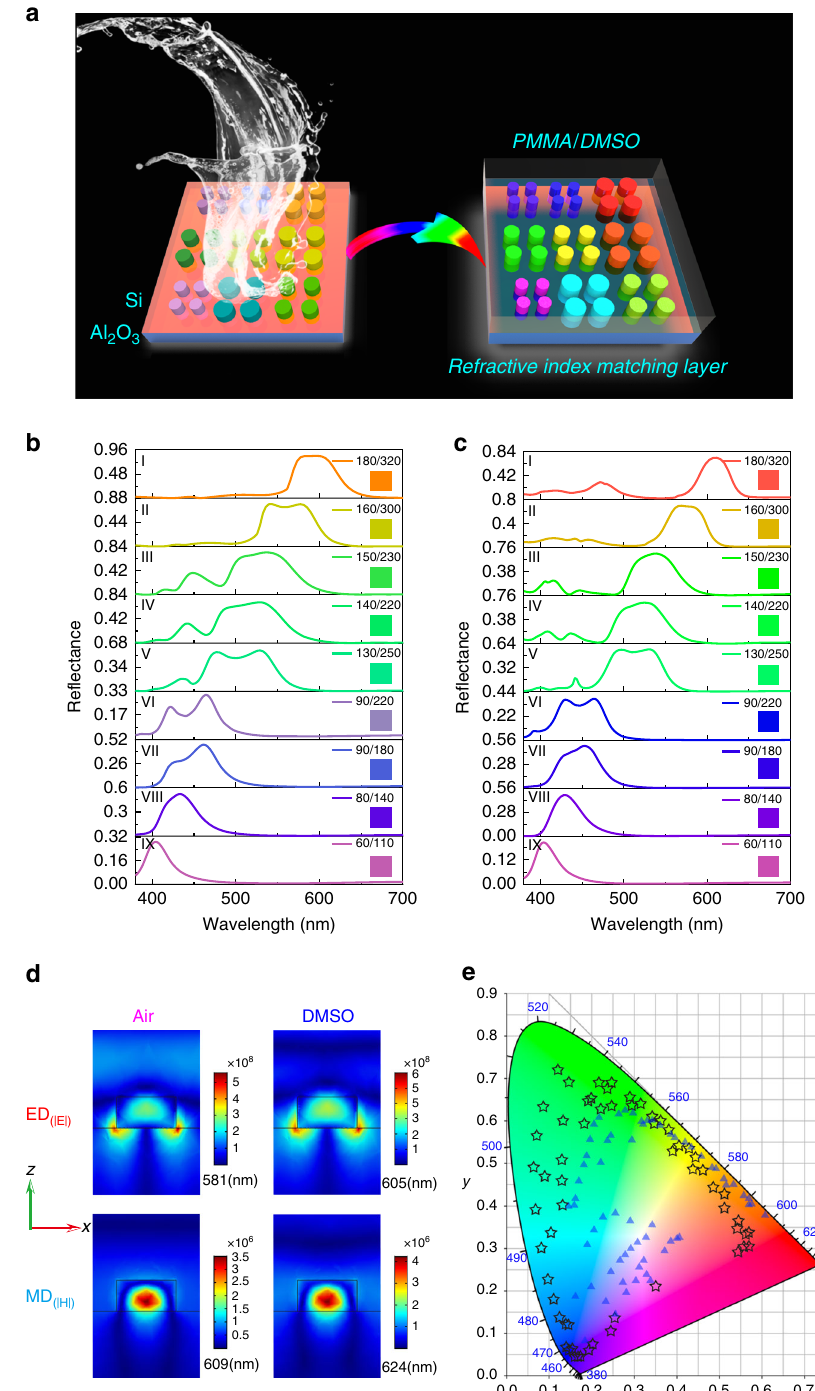
Fig. 2 The schematic and the numerical simulation of Si metasurfaces. a The schematic of the Si metasurfaces. The left panel shows the colors are pale with a background re fl ection in air. The right panel shows distinct colors can be achieved by adding a refractive index matching layer such as PMMA or DMSO. Panel b , c are the calculated re fl ection spectra of Si metasurface with different lattice sizes in air and in DMSO, respectively. The insets are the corresponding structural color. From top to bottom, the panels are labeled as I – IX. d The electromagnetic fi eld distributions of electric dipole mode and magnetic dipole mode in air and in refractive index matching layer with n = 1.48. Here the size parameter is diameter/period of 180/320 nm. e The CIE1931 plot for numerically calculated structural color palettes under Black Body illumination condition. The triangles and stars represent the results in air and in DMSO